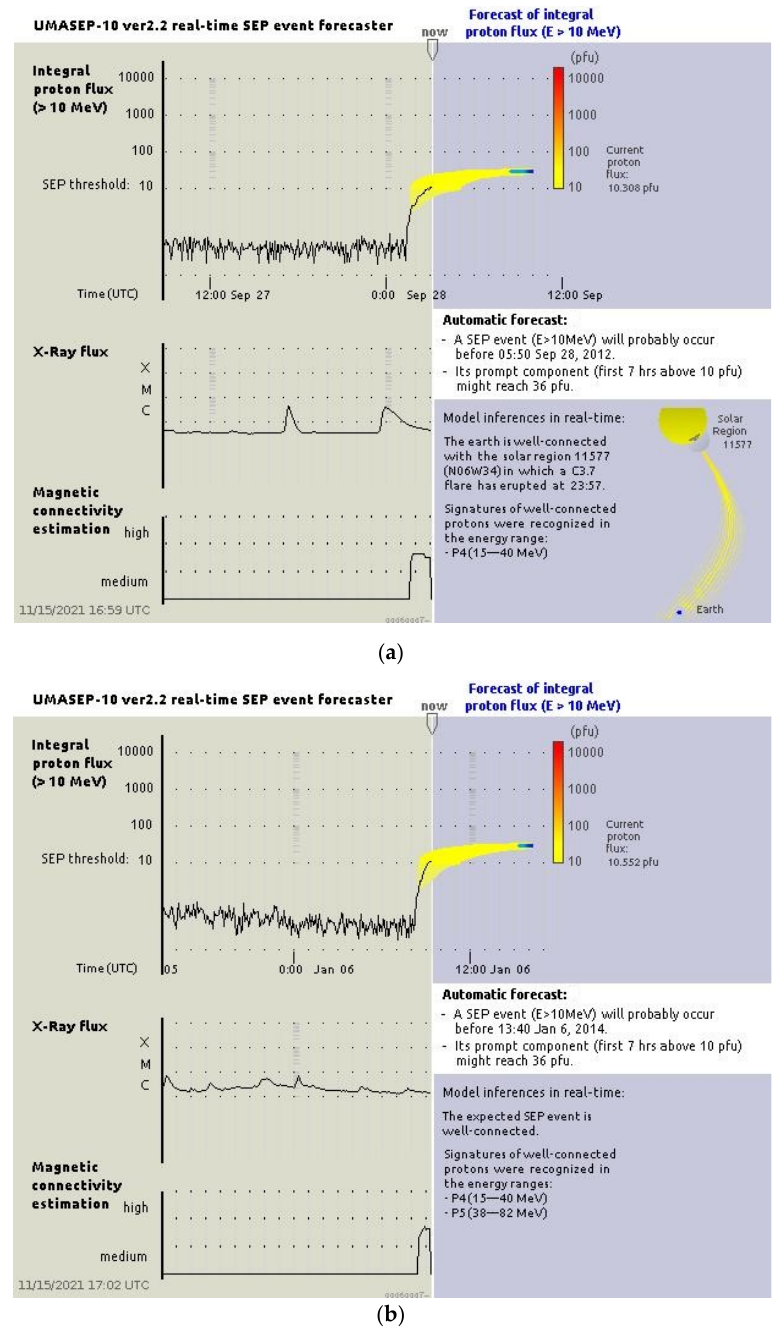
Figure 5. Predictions of UMASEP-10 version 2 for two SEP events associated with <C4 flares. ( a ) Prediction for the event on 27 September 2012, which was associated with a C3 flare that took place at N08W41. ( b ) Prediction for the SEP event on 6 January 2014, which was associated with a C2.2 flare that took place at S13W83.